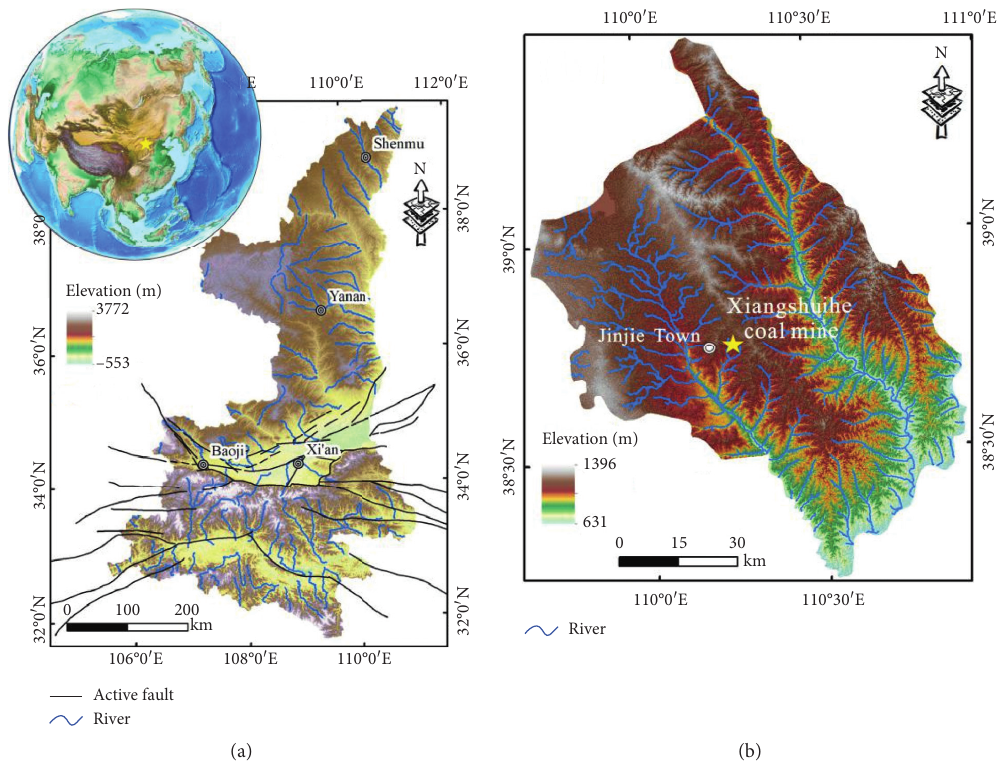
Figure 1: (a) Location of Shenmu city, Shaanxi Province, China. (b) Digital elevation model showing Shenmu city and Xiangshuihe Coal